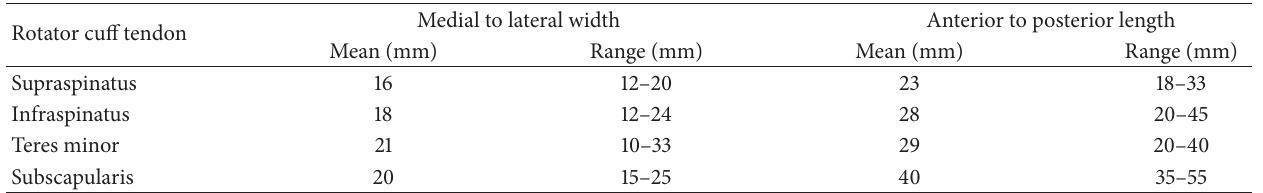
Table 1: Medial to lateral width and anterior to posterior length of the rotator cuff tendon insertions.